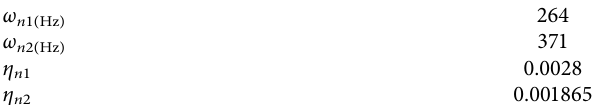
Table 2: Two natural frequencies and related damping ratio from numerical